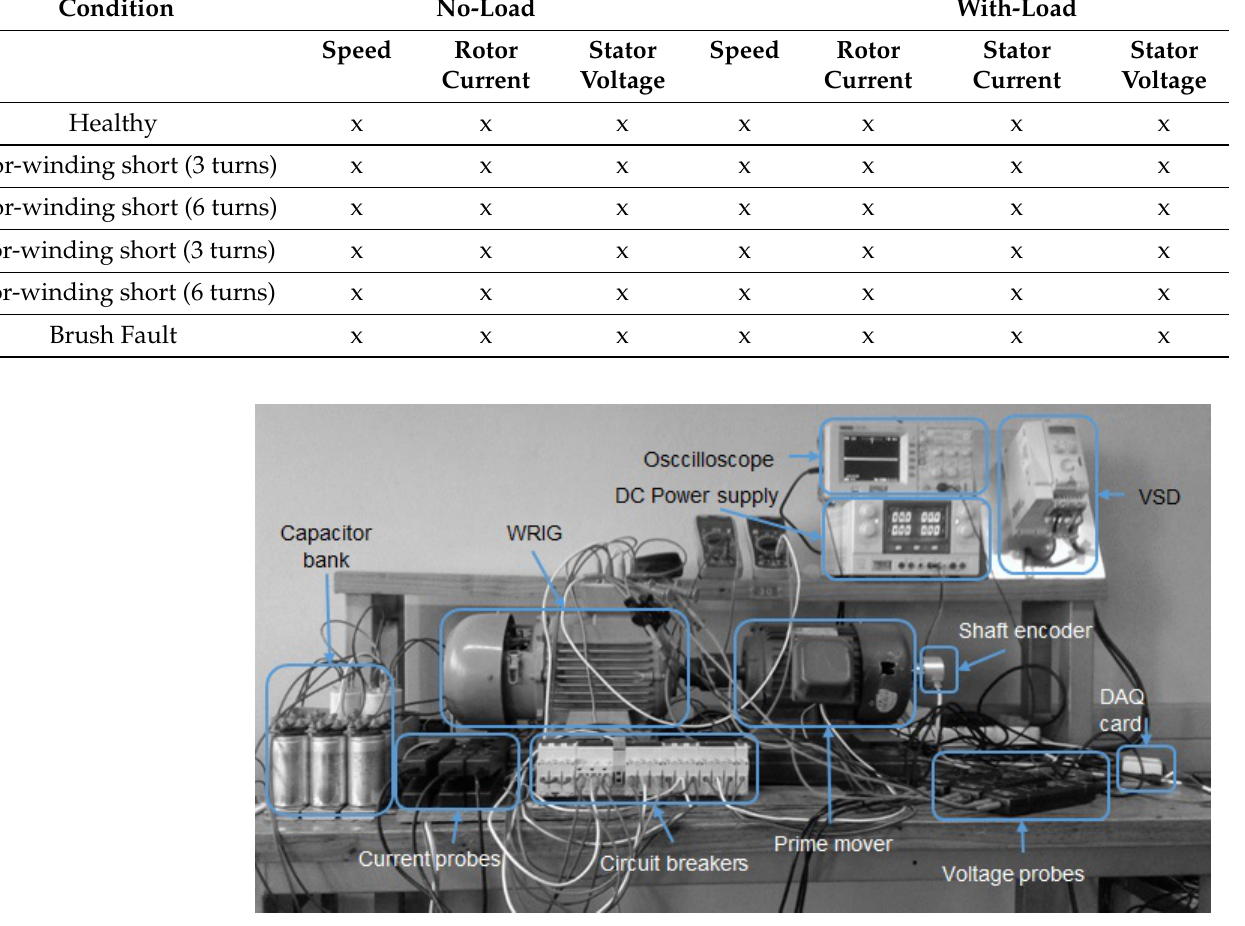
Figure 2. Experimental